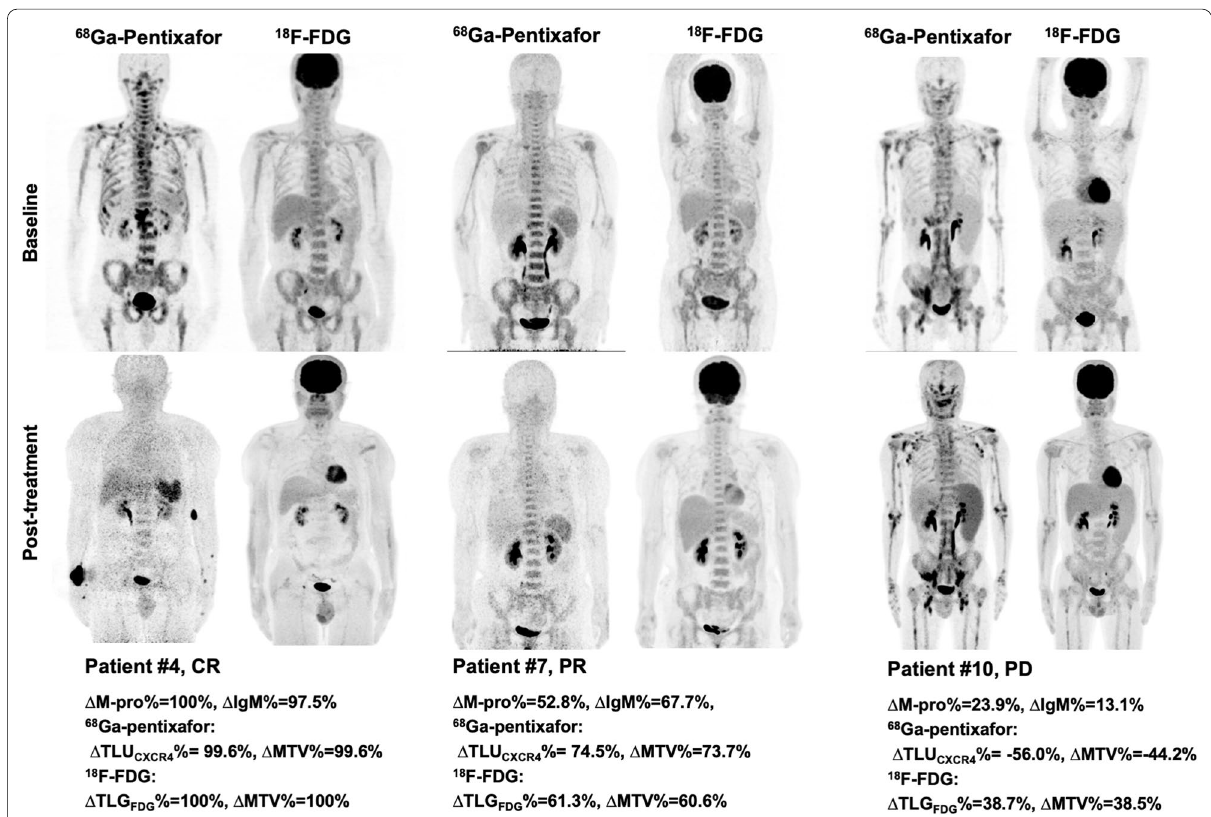
Fig. 1 Examples of 3 patients with clinical CR, PR, and PD after chemotherapy showing different response in 68 Ga-pentixafor and 18 F-FDG PET/CT.